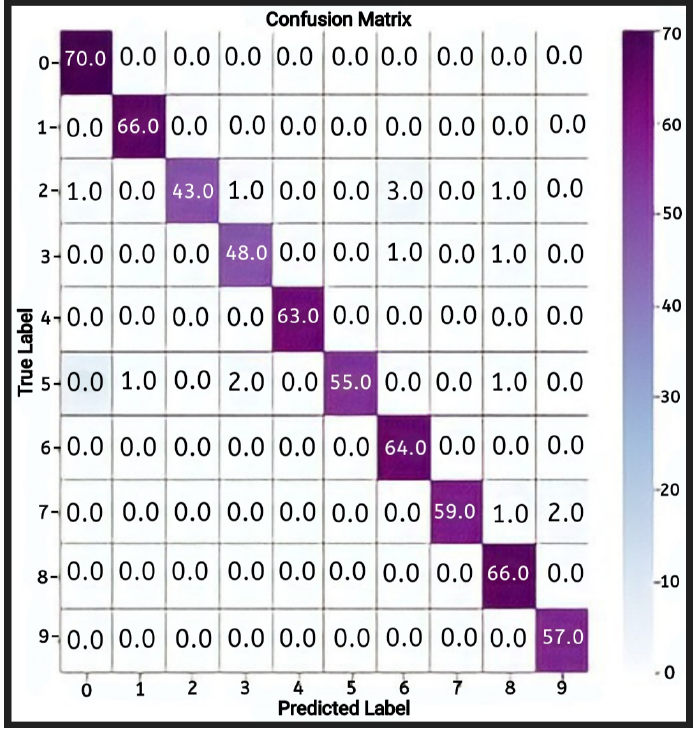
Figure 15. Confusion matrix for the CNN